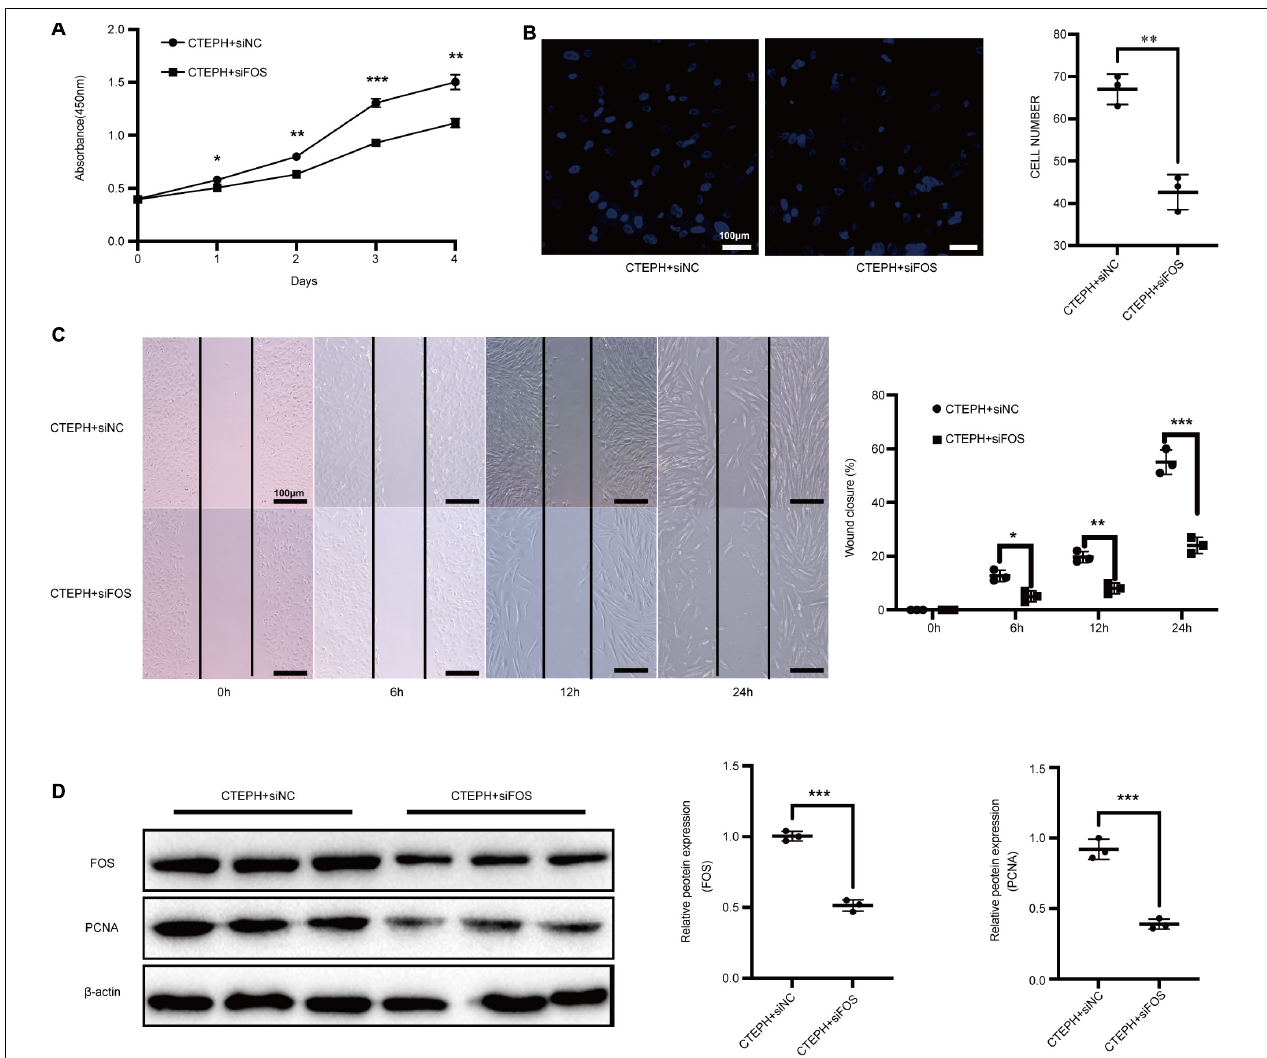
FIGURE 8 | Inhibition of FOS attenuates the proliferation and migration of VSMCs in CTEPH. Proliferation and migration of CTEPH VSMCs as measured by (A) CCK-8 assay, (B) transwell assay, and (C) scratch-wound assay after treatment with FOS-siRNA for 24 h. (D) Western blot analysis of FOS and PCNA in CTEPH VSMCs after treatment with FOS-siRNA for 24 h. N = 3, results are expressed as the mean ± SD, * p < 0.05, ** p < 0.01, and *** p < 0.001. Data were analyzed using student t -test.